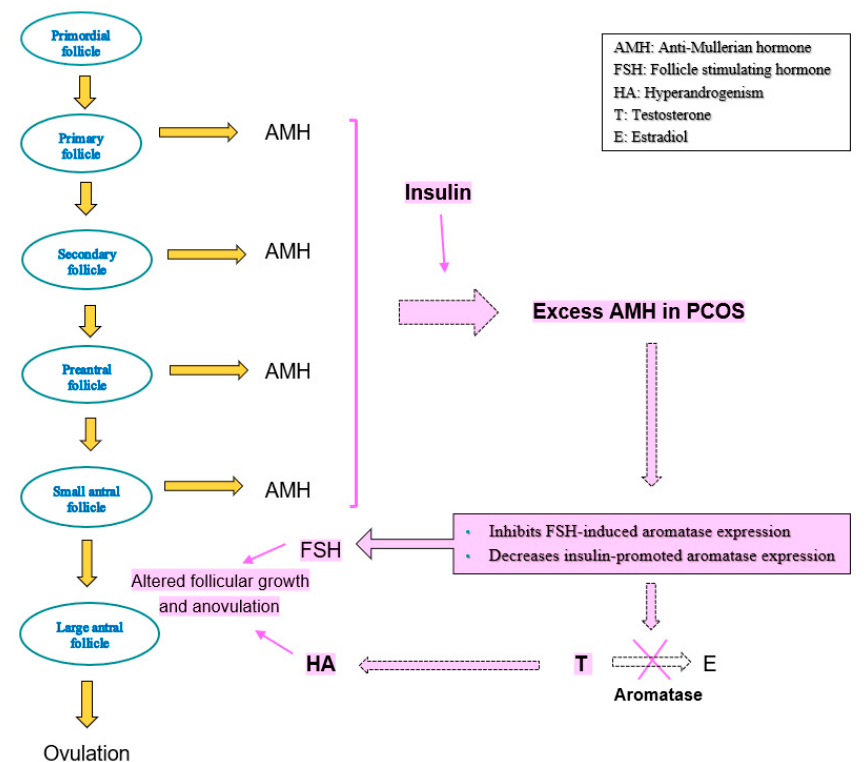
Figure 3. Schematic representation of ovarian follicular development, AMH secretion, excess production in PCOS, its possible inhibitory effect on FSH and aromatase, and contribution to hyperandrogenism and altered follicular growth.